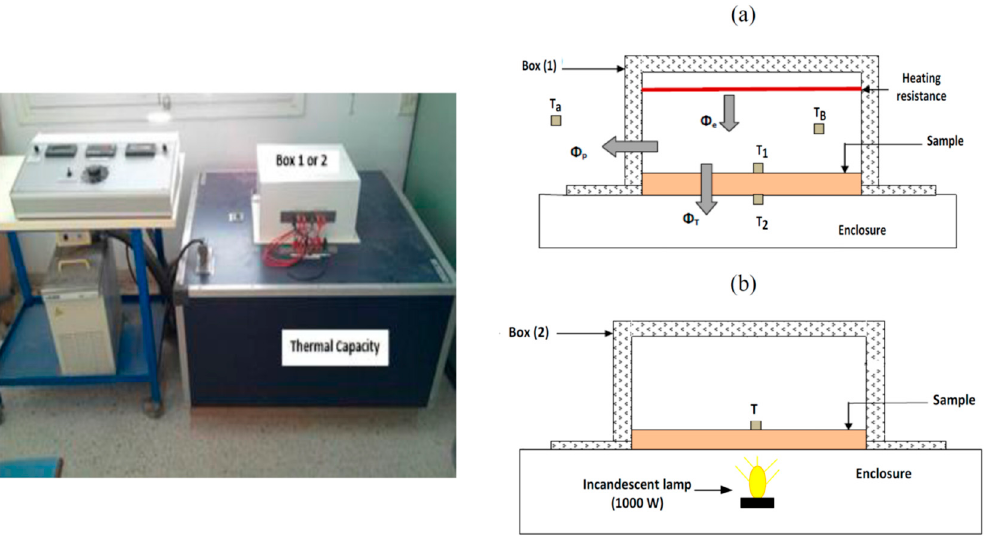
Figure 5. Box method device. ( a ) Thermal conductivity measurement. ( b ) Thermal diffusivity meas- urement.